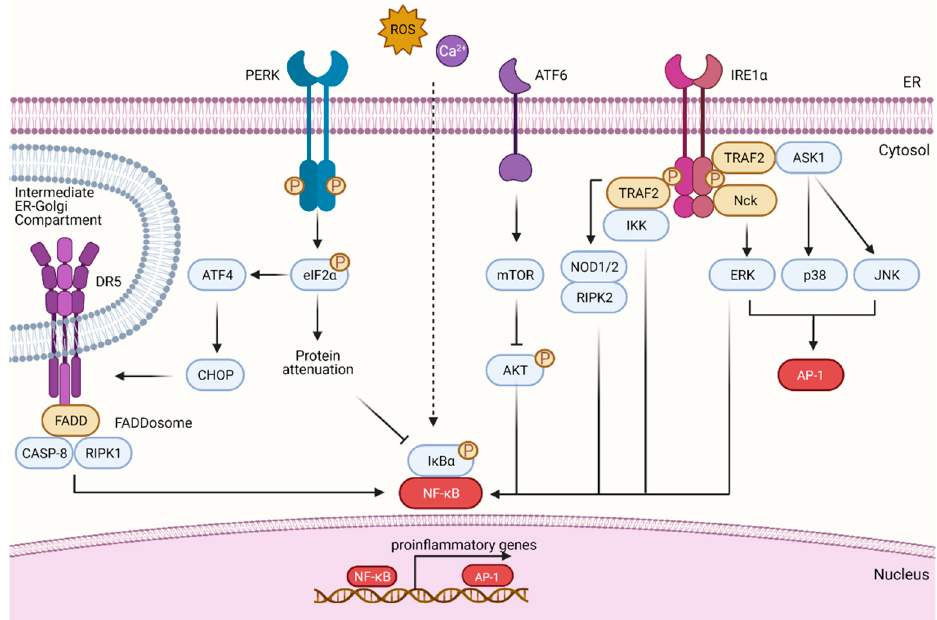
Figure 3. Proinflammatory pathways activated by ER stress. In the case of ER stress, Ca 2+ release and ROS or UPR sensors may engage proinflammatory pathways. Indeed, through translation attenuation, PERK promotes NF- κ B activation by reducing protein translation of its inhibitor I κ B α . PERK/ATF4/CHOP axis is also responsible for DR5 upregulation that has been recently linked to the activation of NF- κ B through the FADDosome. IRE1 can exert a scaffolding function leading to the assembly of a protein platform called UPRosome that comprises different adaptor and regulatory proteins, such as TRAF2, involved in proinflammatory processes. TRAF2 can activate NF- κ B through NOD1, NOD2 and RIPK2 or by the recruitment and activation of IKK. TRAF2 can also recruit ASK1 leading to the activation of JNK and p38 and the downstream AP-1. IRE1 α can also recruit Nck that activates ERK and in turn, NF- κ B and/or AP1. ATF6 may also control NF- κ B through mTOR-mediated AKT dephosphorylation.